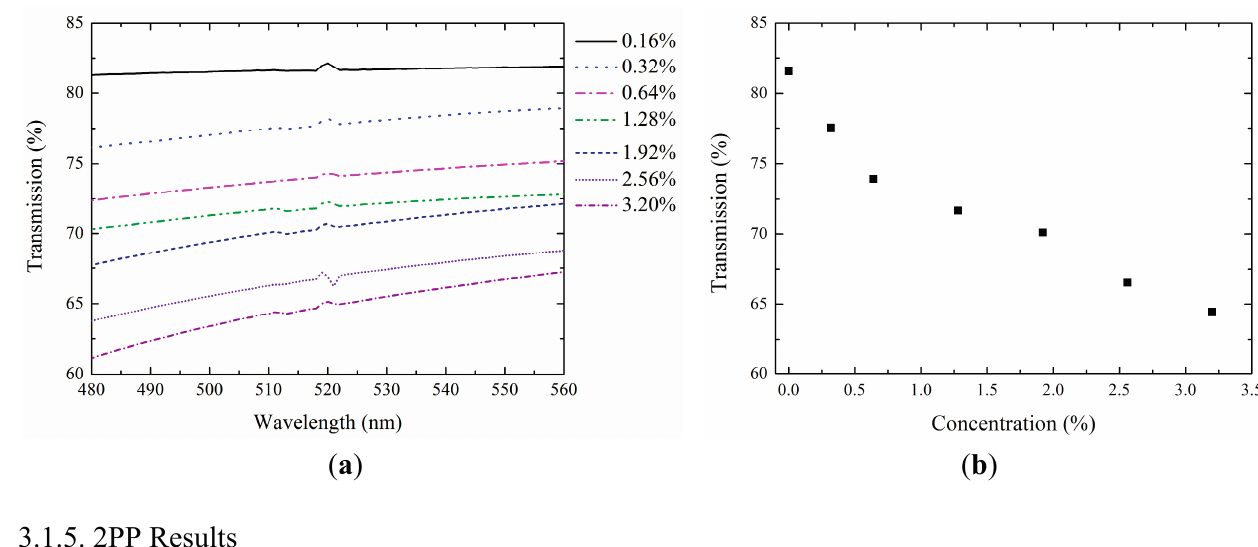
Figure 9. ( a ) Transmission spectra of the composite in the wavelength 480–560 nm; and ( b ) Additionally the transmission at 2PP processing wavelength 515 nm with different nanoparticle TiO 2